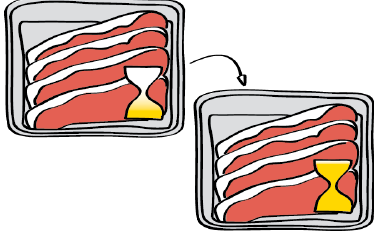
Figure 4. Schematic of an intelligent packaging concept with an indicator (source: intelligent packaging leaflet [33]).